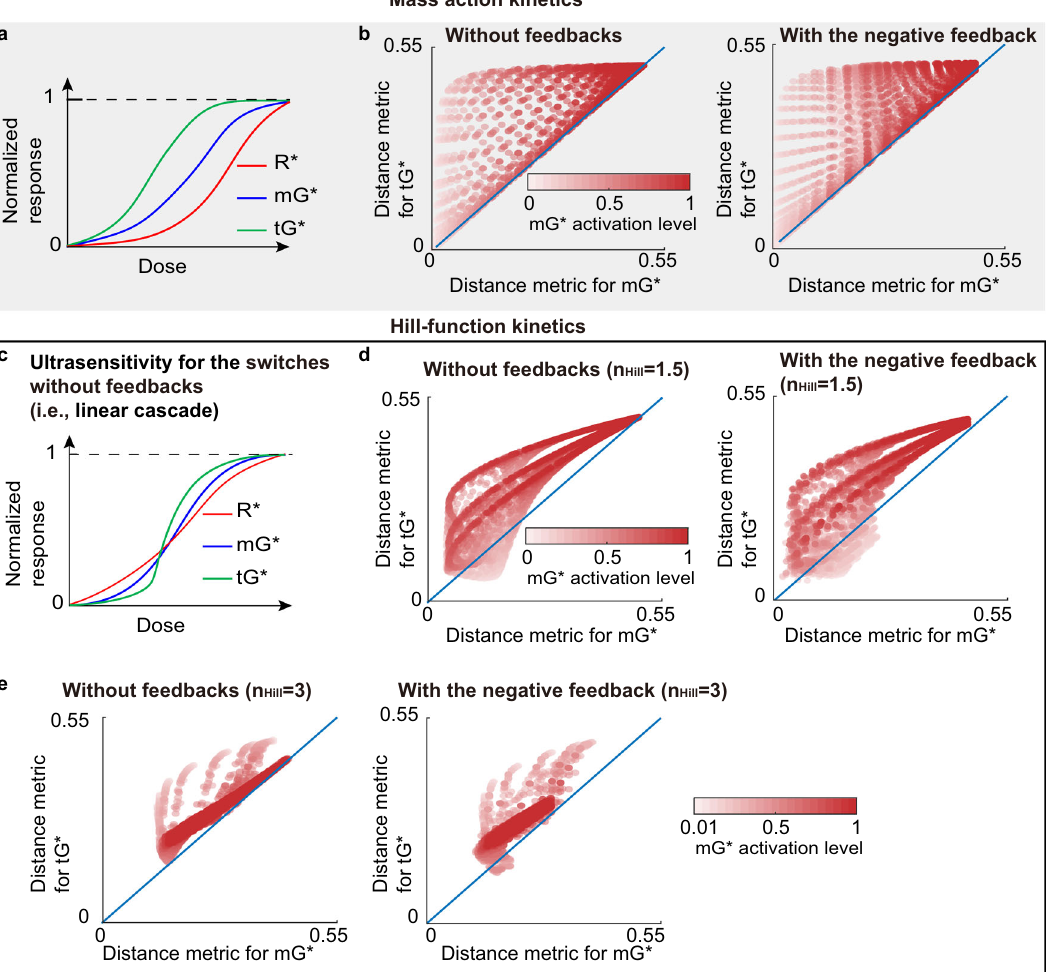
Fig. 5 DoRA in a longer cascade can be obtained using Hill-function kinetics and low mGTPase activation level. a The DoRA of mGTPase is better than that of tGTPase in the mass action model. This is because tG (cid:1) ss metric for mGTPase vs tGTPase in the mass action model. Each dot corresponds to a set of kinetic parameters. The blue line is the diagonal line. The left and right panels correspond to the case without and without feedback, respectively. The number of kinetic parameter sets is one- fourth of that in Fig. 2b(3). c The ultrasensitivity for the circuit without feedback where the Hill-function kinetics is adopted. d – e Same plots as in ( b ) except that the model is Hill-function based with the Hill coef fi cient 1.5 ( d ) or 3 ( e